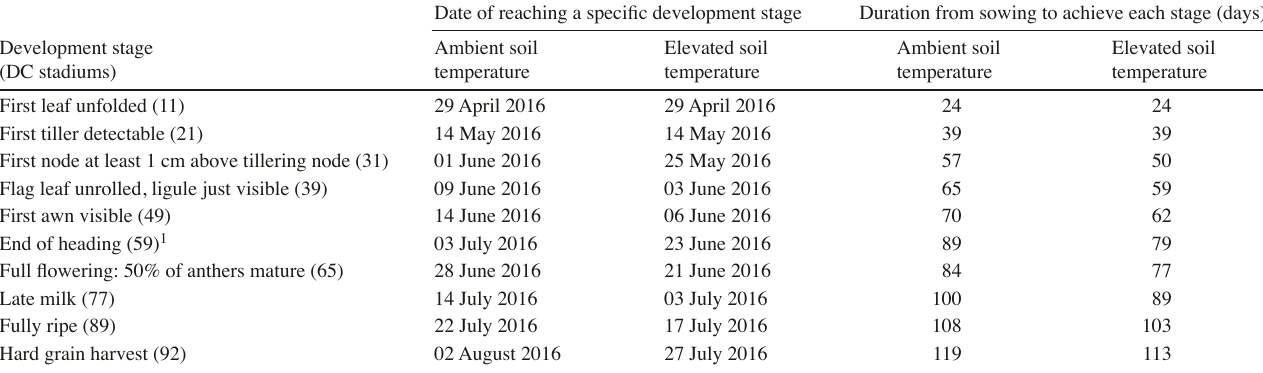
Tab. 2: Duration of growth stages from sowing until final harvest of spring barley. Decimal code (DC) was used to quantify the growth stages ( M eieR , 2001) . Sowing date: 05 April 2016. Final harvest of plants grown under ambient and elevated soil temperature were on 02 August 2016 and 27 July 2016,